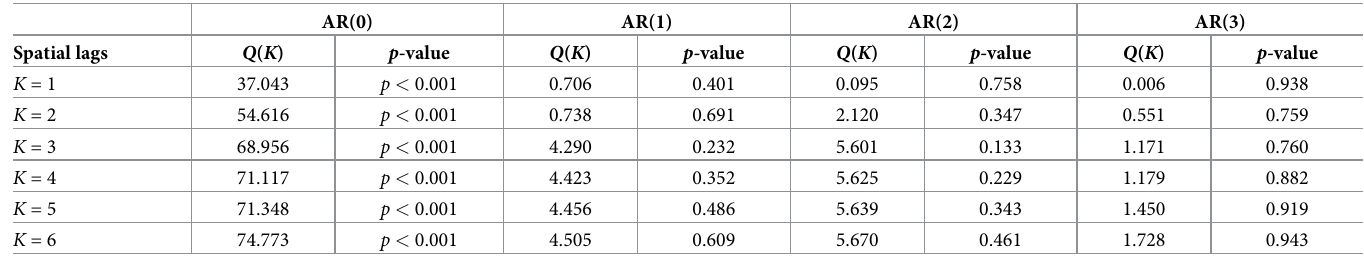
Table 6. Goodness-of-fit for fitted spatial autoregressive models. Obtained p -values for error terms of the spatial AR(0), AR(1), AR(2) and AR(3) models ( n = 62). AR(0) AR(1) AR(2) AR(3) Spatial lags